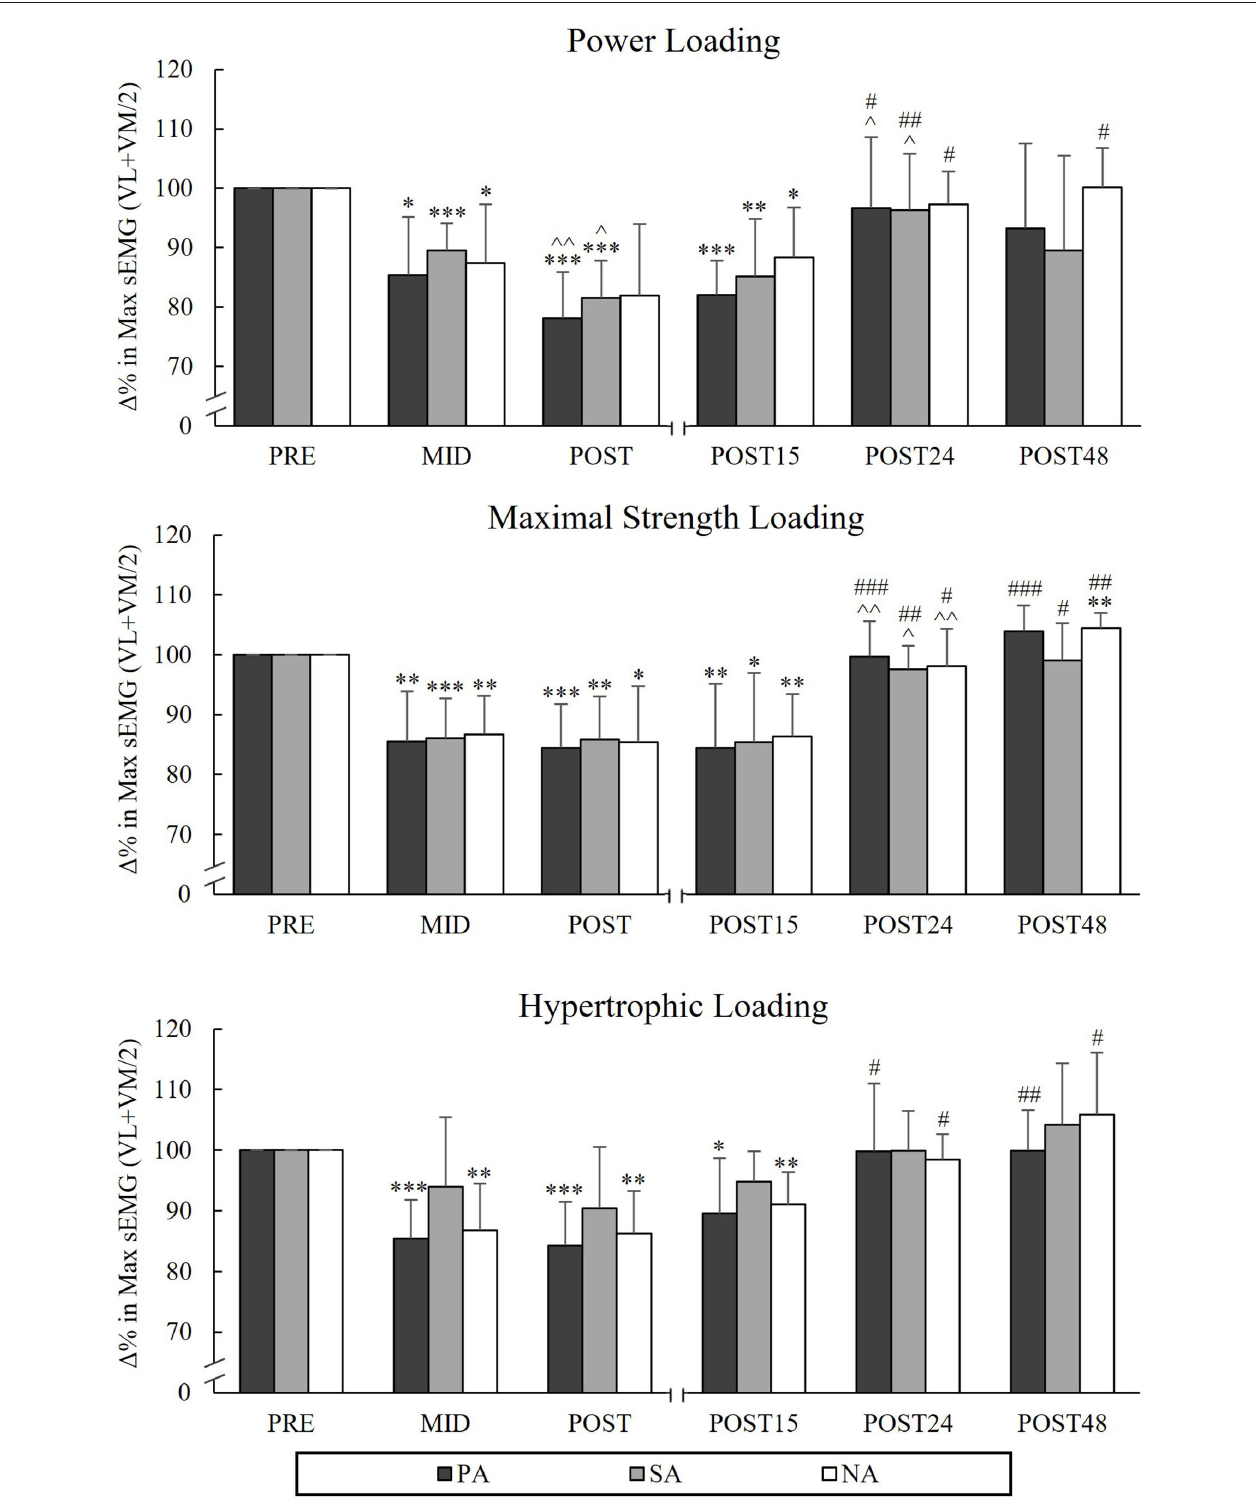
FIGURE 6 | Relative changes in maximal averaged sEMG amplitudes of VL and VM muscles during the concentric phase of maximal power back-squat during three resistance exercise loadings in power (PA), strength (SA), and non-athletes (NA). * p < 0.05, ** p < 0.01, *** p < 0.001 refer to within-group significances compared to Pre. ∧ p < 0.05, ∧∧ p < 0.01 refer to within-group significances compared to the previous time point. # p < 0.05, ## p < 0.01, ### p < 0.001 refer to within-group significances compared to Post during recovery.